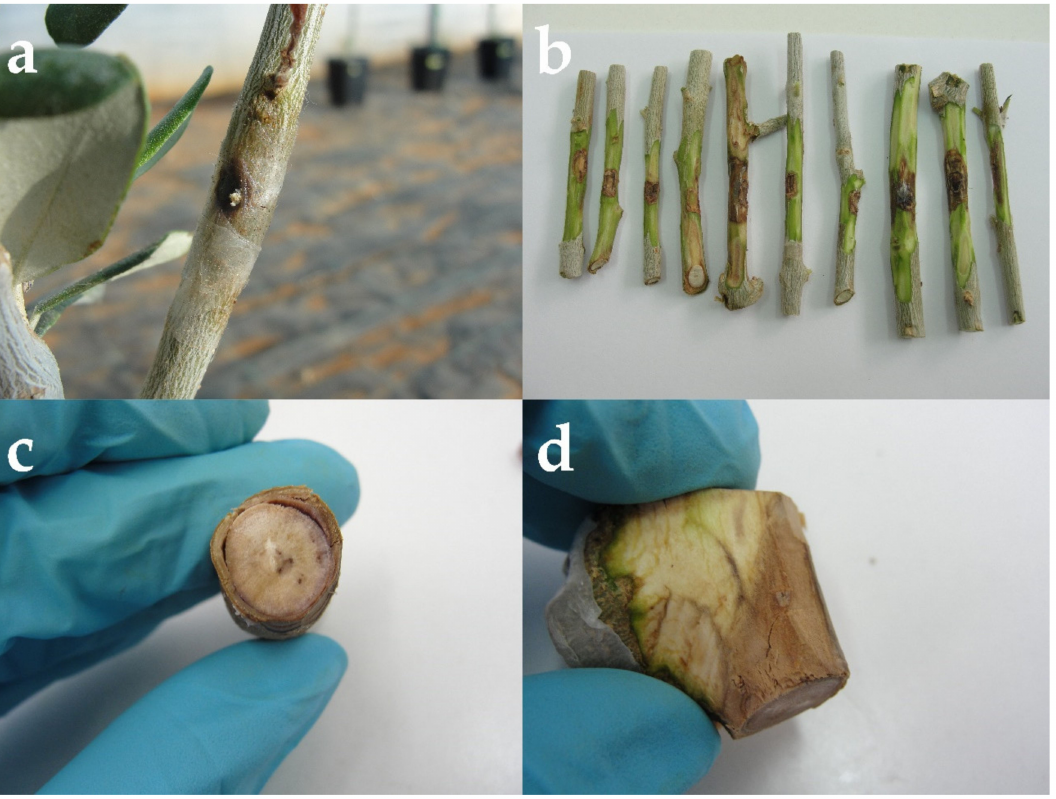
Figure 3. ( a – d ) Disease symptoms on branches used in pathogenicity tests from March to July